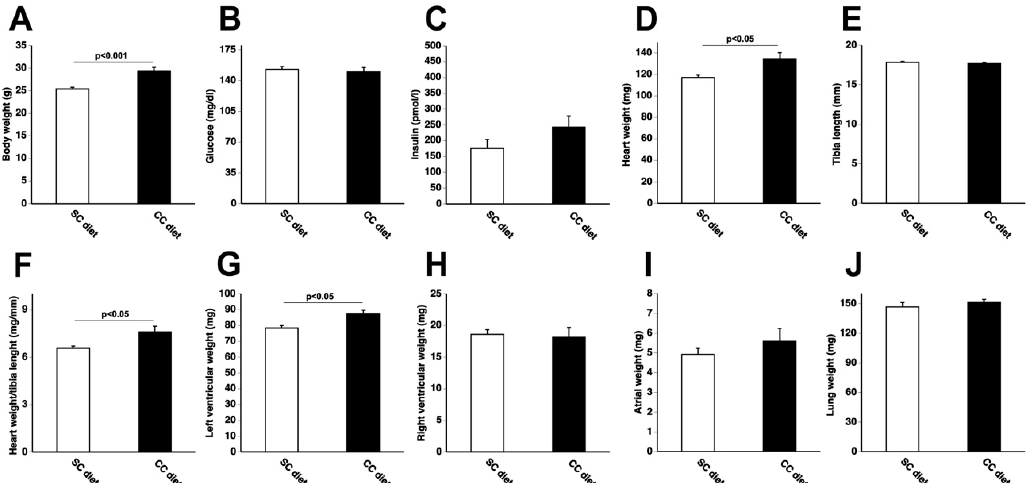
Figure 1. Schematic representation of the study desi.